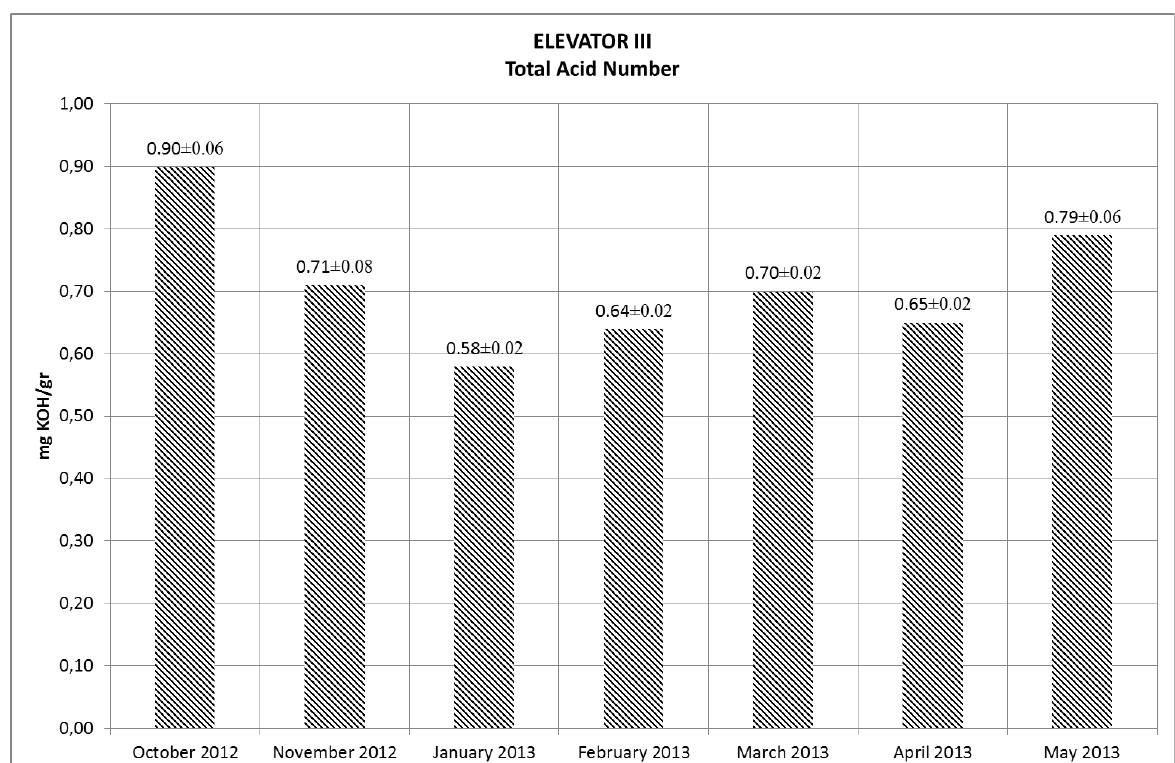
Figure 7. Total Acid Number of Elevator